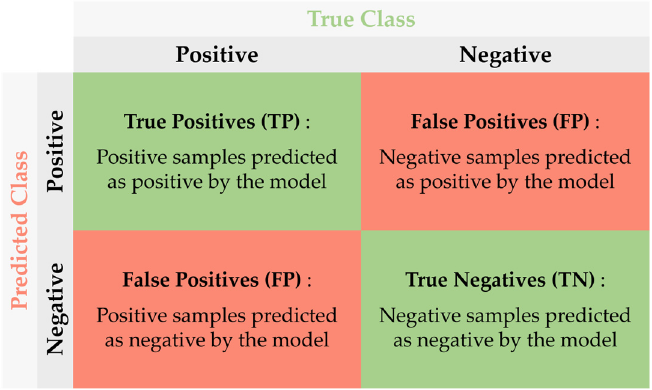
Figure 5. Definition of the confusion matrix in the binary classification.